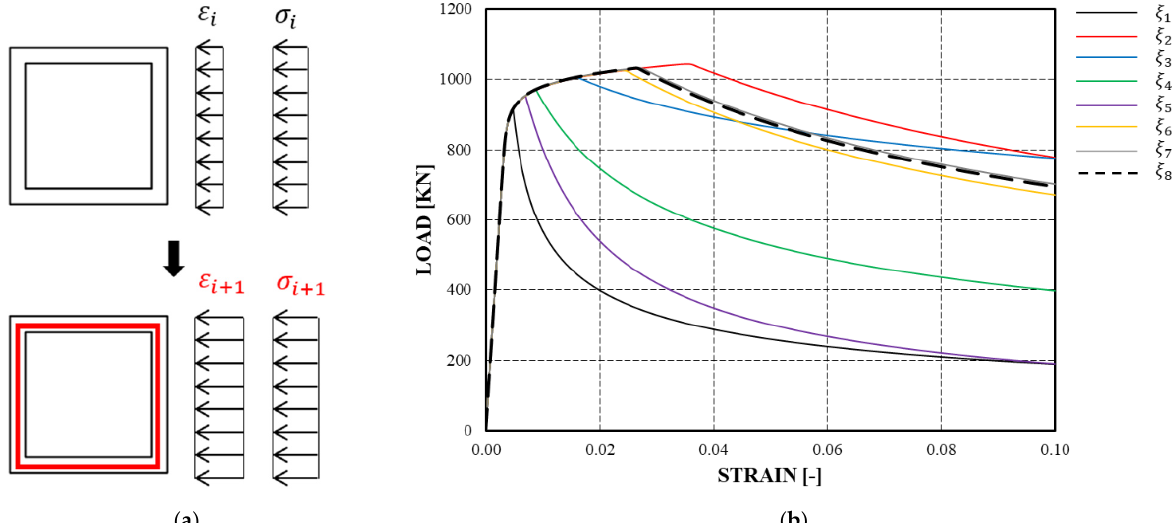
Figure 4. Scheme of a generic box section in compression ( a ). The load-strain curves by varying the plastic coefficient 𝜉 ( b